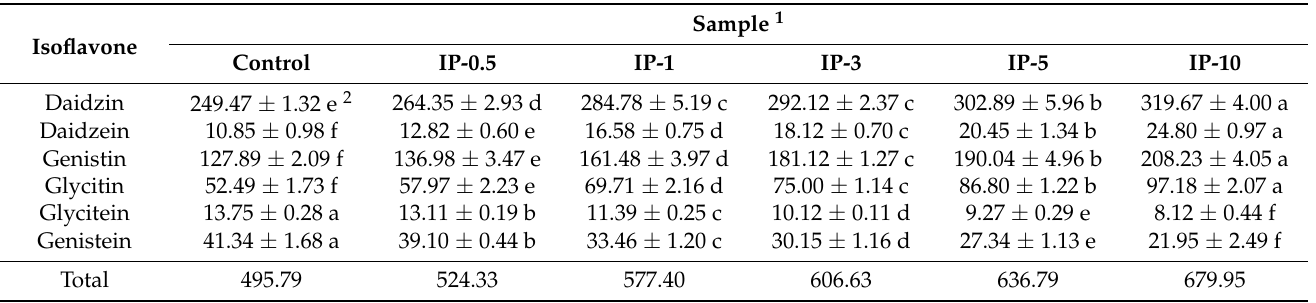
Table 4. Isoflavone content (mg/kg dry weight) of soybean sprouts cultivated after different concen- trations of illite treatment.